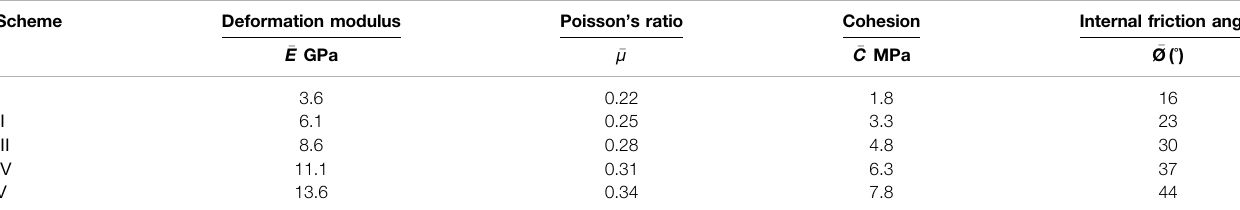
TABLE 2 | Levels of test factors. Scheme